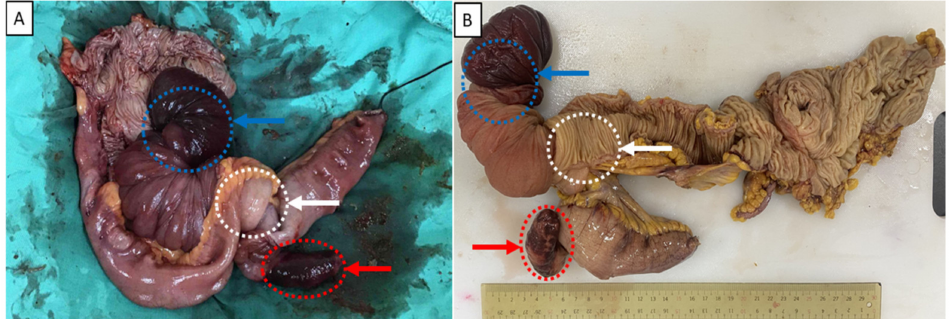
Figure 3. Macroscopic examination of the surgical specimen. ( A ) Macroscopic examination of the surgical specimen during surgery revealed a polypoid-shaped mass measuring 2.2 × 2.0 × 1.5 cm, arising from the mucosal surface at the distal ileum (Red arrow), which resulted in ileocolic (white circle) and ileoileal intussusceptions with an ischemic change at the terminal ileum (blue circle); ( B ) The surgical specimen was carefully incised transversely from the ascending colon to the cecum, and the ileocolic (white circle) and ileoileal intussusceptions were observed clearly. A polypoid- shaped mass measuring 2.2 × 2.0 × 1.5 cm, arising from the mucosal surface at the distal ileum (Red arrow).